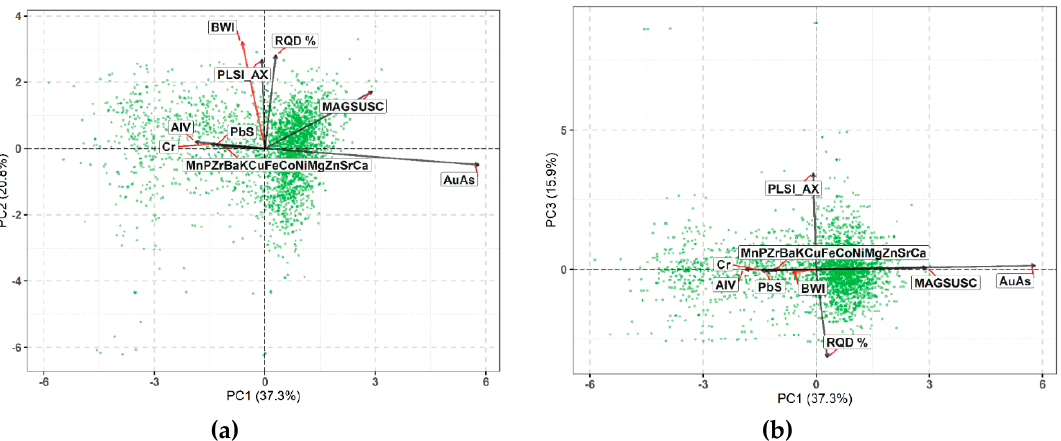
Figure 16. Biplots for fresh rock observations. Green data points represent PC scores and the arrow vectors represent the orebody variables. The BWI loading is shown in red for clarity. ( a ) Biplot of PC1 and PC2 (57.3% variance). ( b ) Biplot of PC1 and PC3 (53.2% variance).